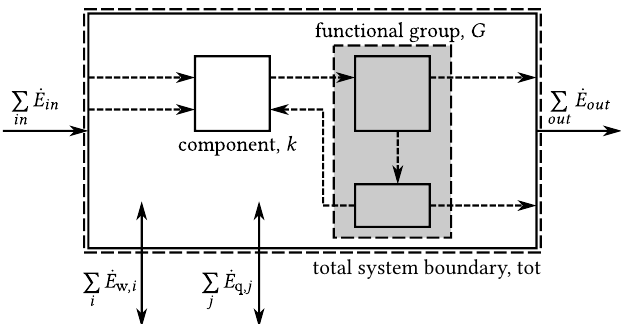
Figure 1. Exergy balance of an open